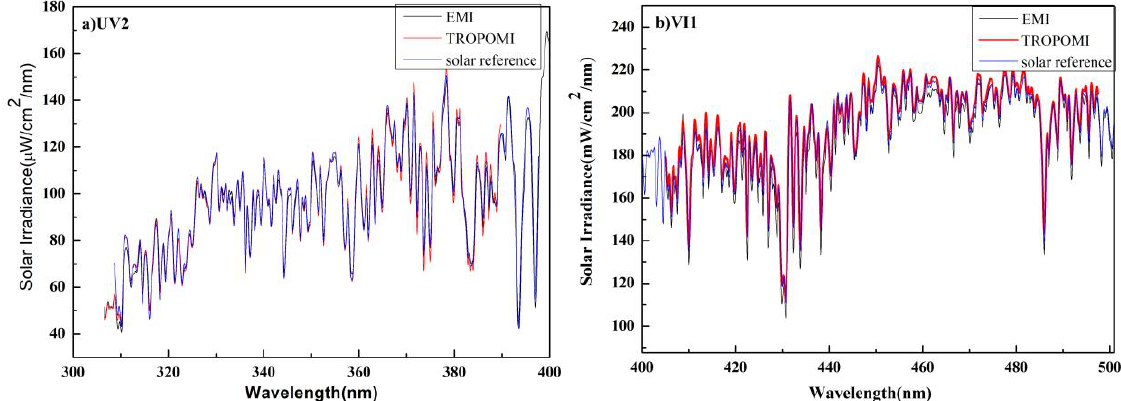
Figure 7. The irradiance spectra in ultraviolet ( a ) and visible ( b ) bands measured by EMI-2 (black) and TROPOMI (red) on 23 December 2021. The blue line is from SAO2010 solar irradiance reference spectrum and convolved with the ISRF of EMI-2.